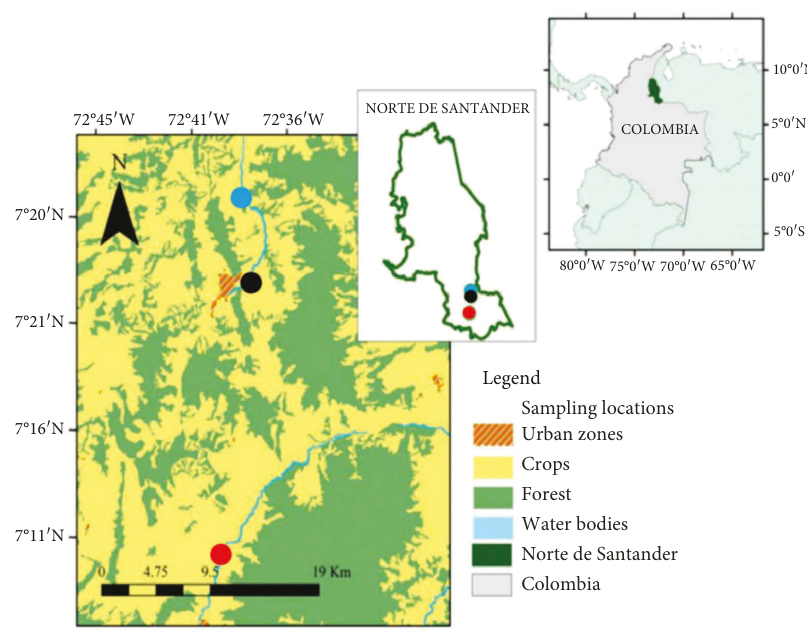
Figure 1: Sampling